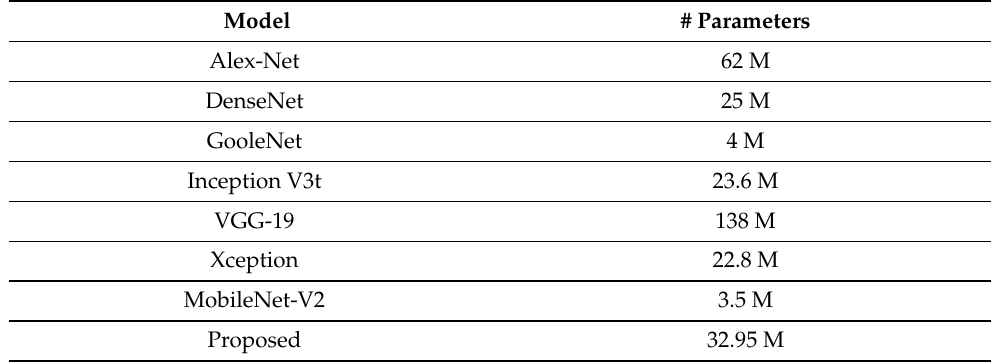
Table 10. The number of trainable parameters for the most prevalent deep models in millions (M).